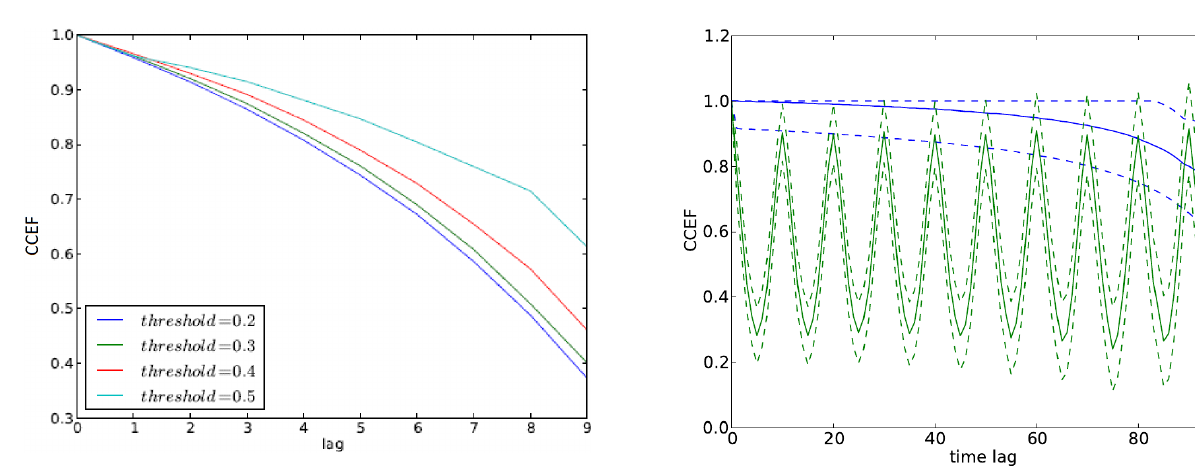
Figure 2. CCEF for the indexed flow networks with increasing flow-width parameter c , and for different threshold values of ad- jacency matrices of the flow networks.